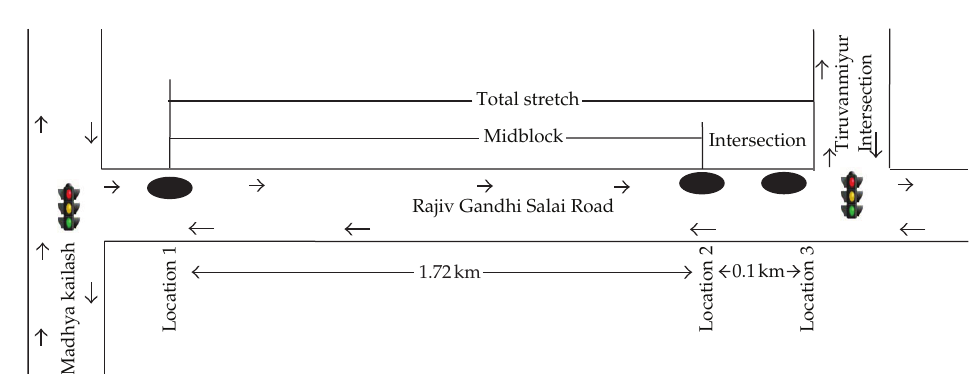
Figure 1: Schematic representation of the study